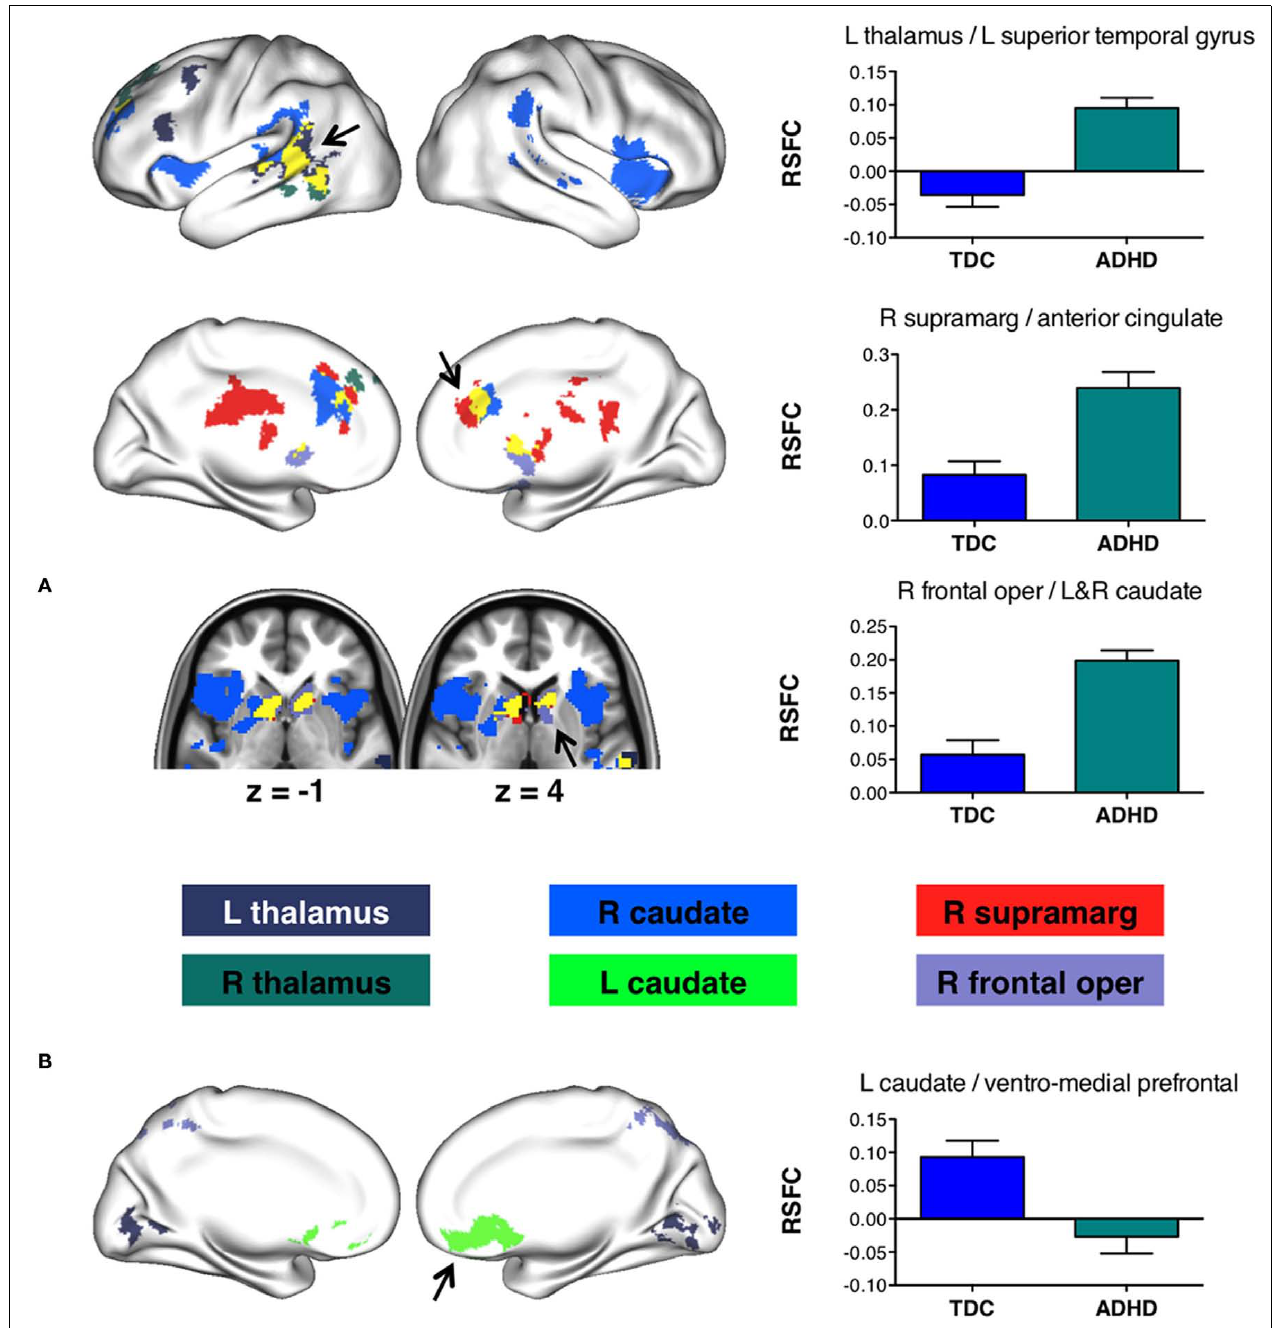
Graphs illustrate example effects for the regions indicated by arrows on the surface renderings. (A) Regions exhibiting a significant ADHD > TDC effect on RSFC. (B) Regions exhibiting a significant ADHD < TDC effect on RSFC. R, right; L, Left; supramarg, supramarginal gyrus; frontal oper, frontal operculum.